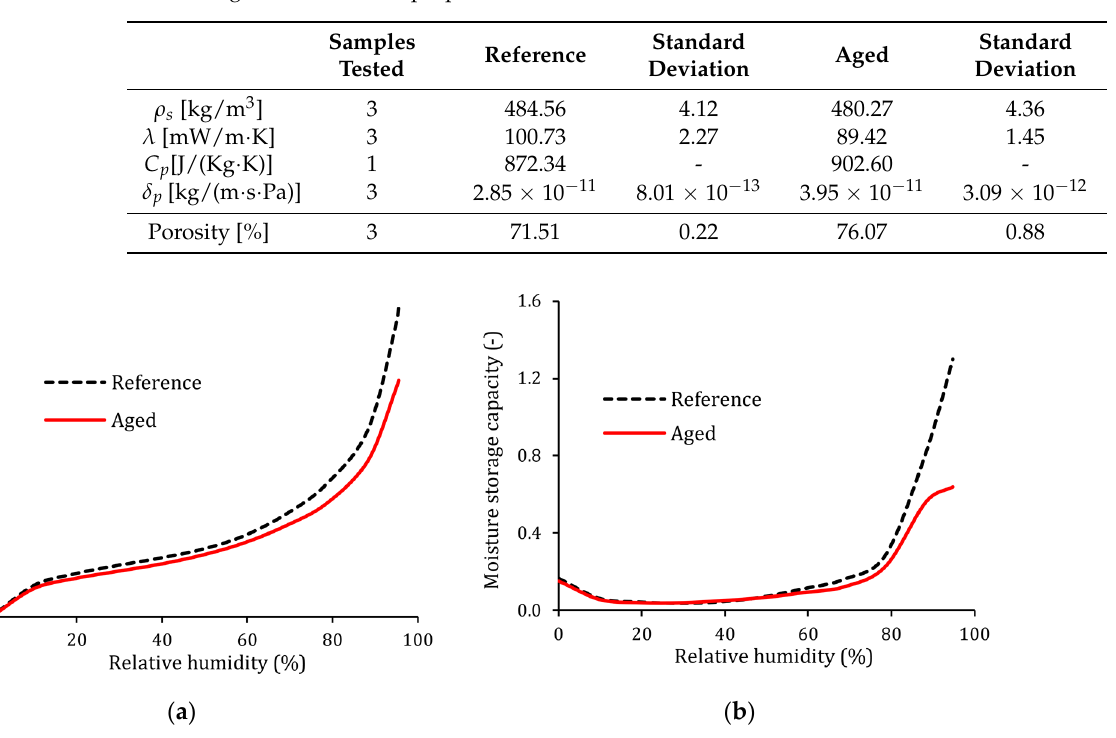
Table 2. Aged and reference properties used to feed the numerical model.